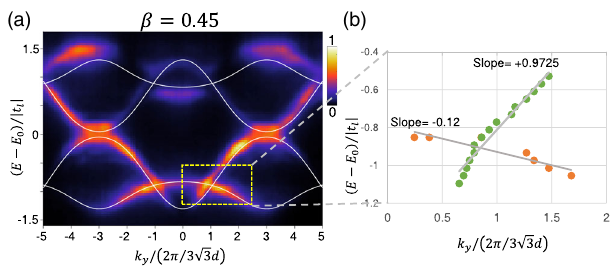
¼ direction for k y x j and j v j , y y